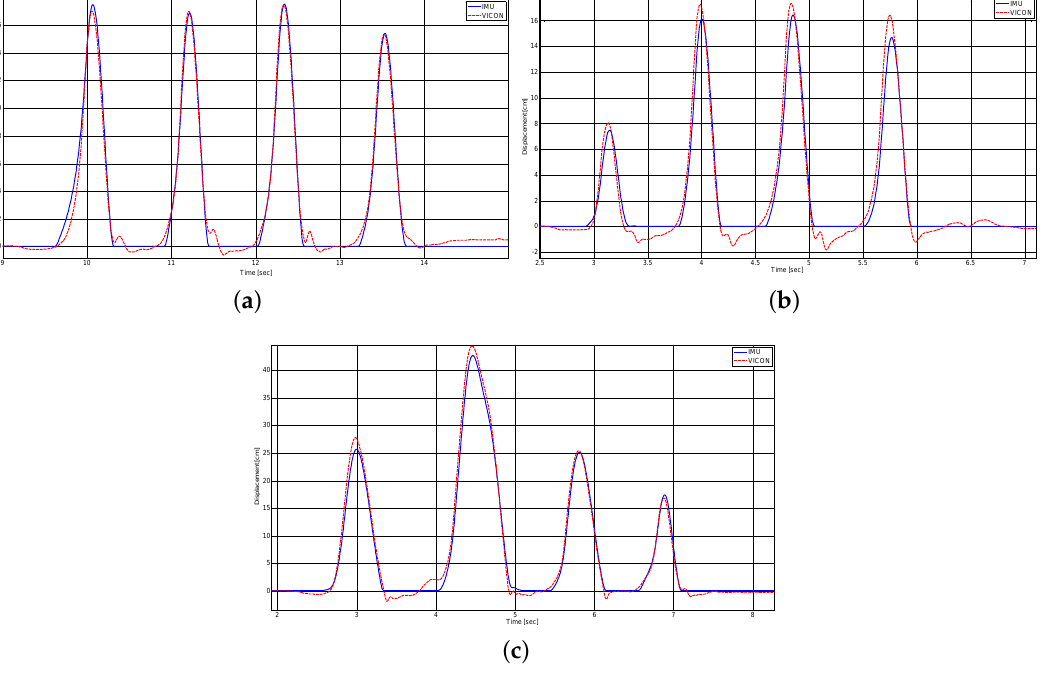
Figure 4. Foot clearance values measured by the VICON system and estimated by the IMU during: ( a ) Normal walking (Subject 1, left foot); ( b ) Fast walking (Subject 1, right foot); and ( c ) Walking with obstacles (Subject 10, right